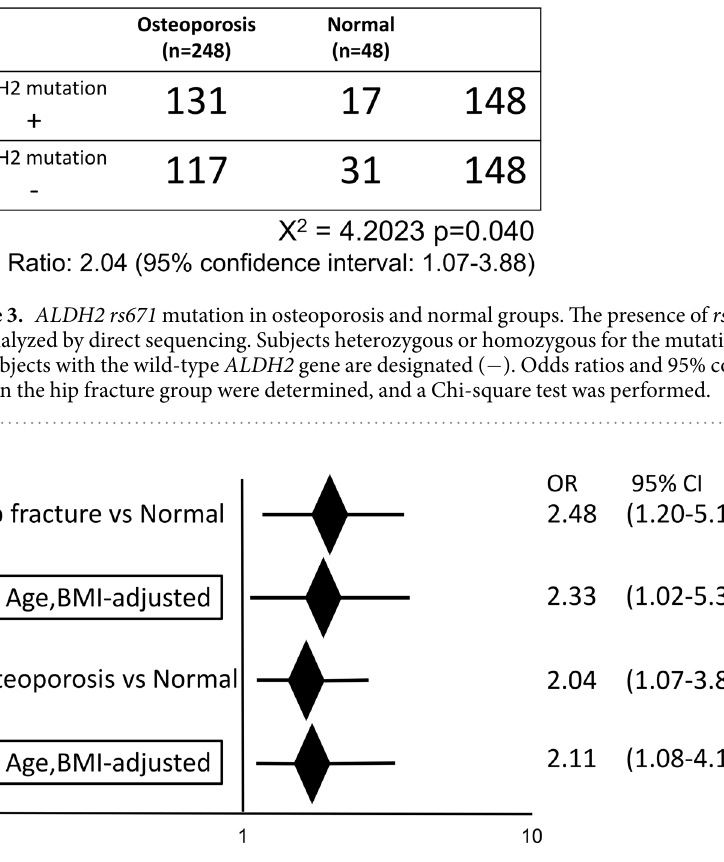
Figure 4. ALDH2 rs671 is associated with hip fracture and osteoporosis. Odds ratio (OR) of rs671 between hip fracture and normal groups, or between osteoporosis and normal groups was determined after adjustment for age and